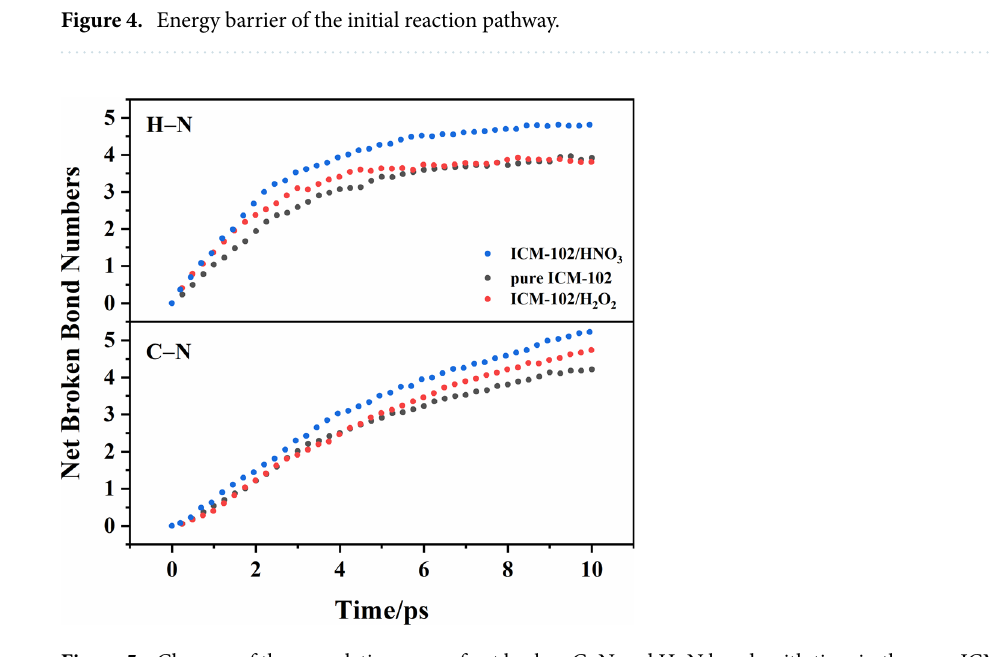
Figure 5. Changes of the cumulative sums of net broken C–N and H–N bonds with time in the pure ICM-102, ICM-102/H 2 O 2 , and ICM-102/HNO 3 systems at 3000